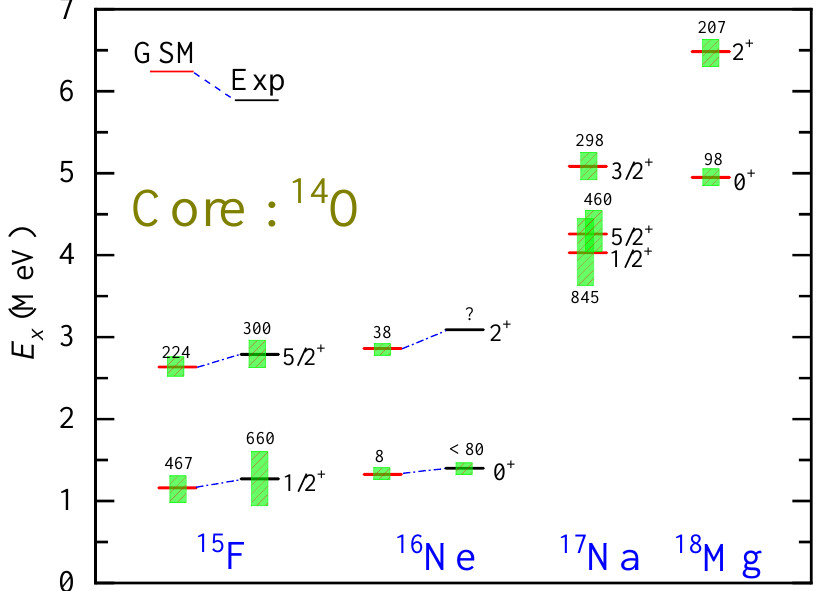
Figure 10. Excitation energies, E x , and widths (in keV) of the ground and excited states of carbon isotones. The GSM calculations are compared to available experimental data [10,100–102]. Energies are given with respect to the 14 O core. Widths are represented by green striped squares, and their explicit values are written above (with permissions from Ref.